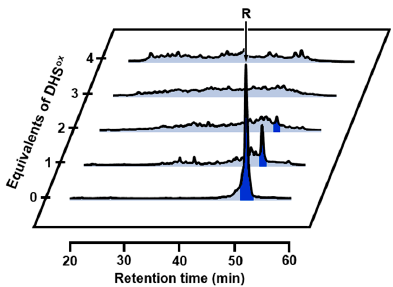
Figure 2. Reverse-phase high performance liquid chromatography (RP-HPLC) chromatograms obtained by the oxidation of R (10 µM) with 1–4 eq trans -3,4-dihydroxyselenolane oxide (DHS ox ) at pH 8.0 and 5 °C in the presence of 10 mM ethylenediaminetetraacetic acid (EDTA). The reaction was acid-quenched after 1 min. For HPLC analysis conditions, see the experimental section.